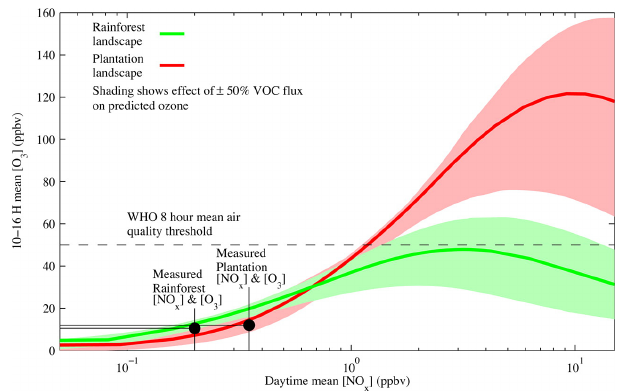
Figure 26. Sensitivity of daytime (10:00–16:00) average ozone concentrations to [NO x ] in the boundary layer for isoprene and monoterpene emission rates measured in a rainforest and palm oil landscape (Hewitt et al., 2009).